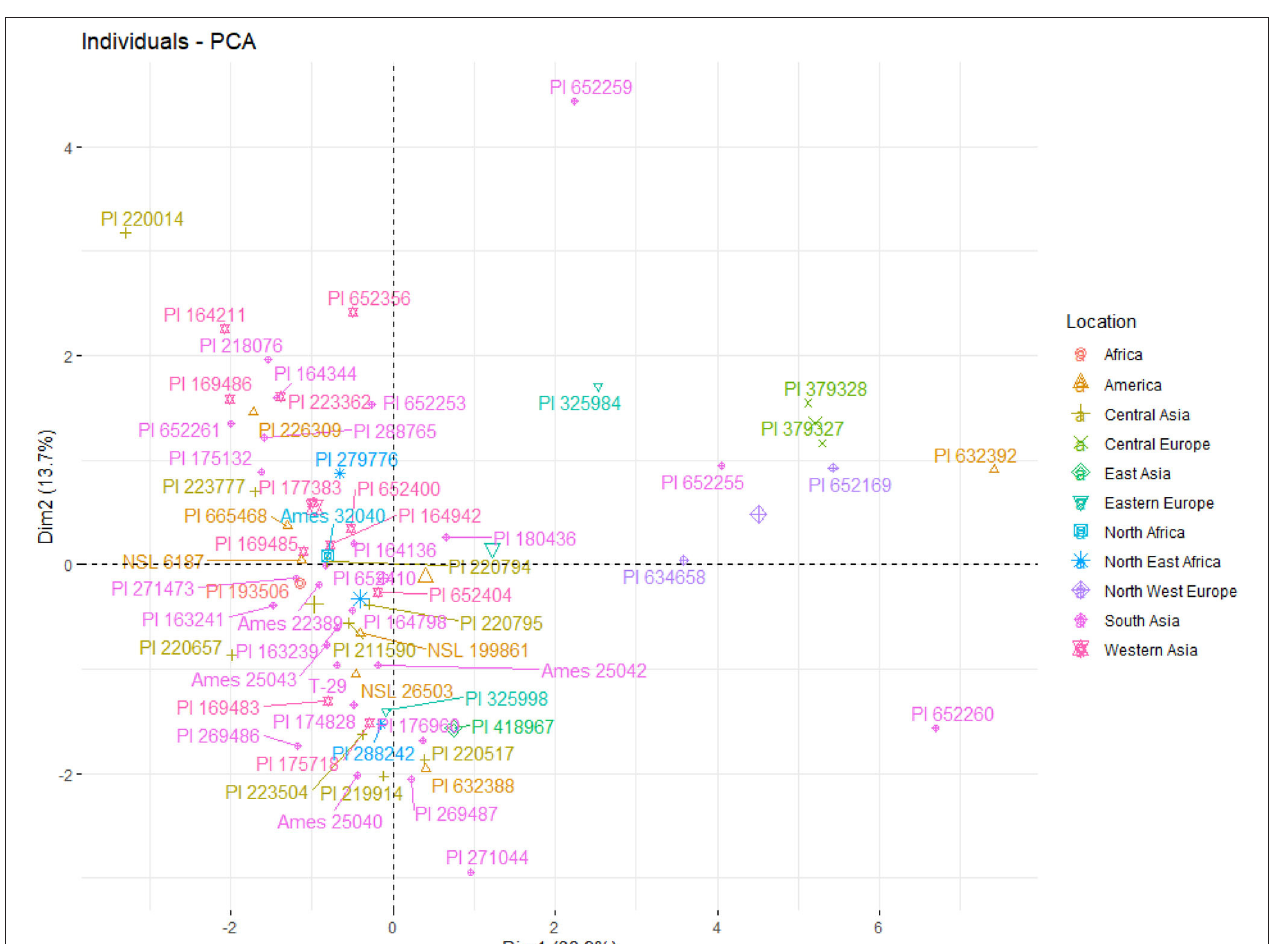
FIGURE 4 | Principal component analysis of 64 carrot genotypes from 17 countries based on nutritional parameters.